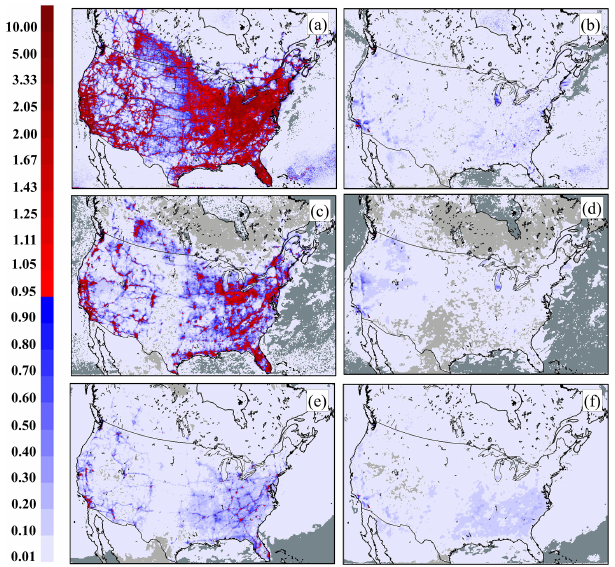
Figure 8. The 90% confidence ratio values (see Eq. 14) for the 29d NO 2 , PM 2 . 5 , and O 3 July 2016 continental 10km domain simula- tions. Panels arranged as in Fig. 7: (a, c, e) 10:00UTC, (b, d, f) 22:00UTC; (a, b) NO 2 , (c, d) PM 2 . 5 , (e, f) O 3 . Values > 1 . 0 indi- cate that the simulations differ at greater than 90%